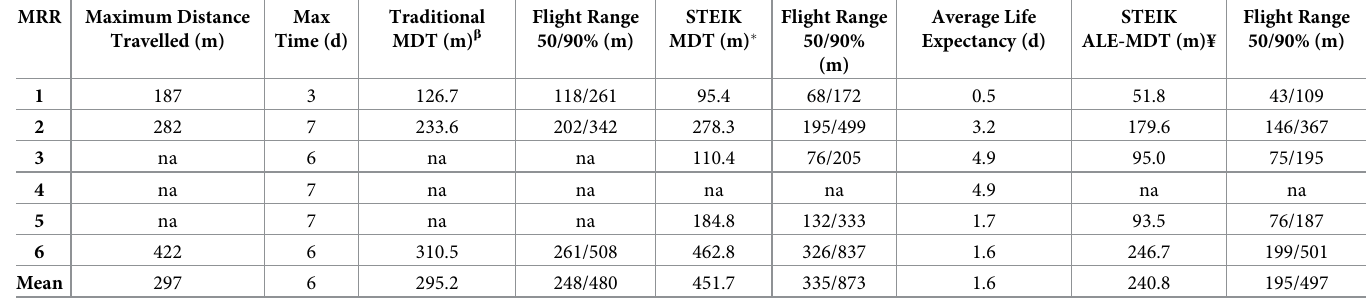
Table 4. Movement estimates male Aedes aegypti from six mark-release-recapture experiments in South Innisfail, Australia. Spatially and Temporarily Evolving Iso- tropic Kernel (STEIK) framework compared with the traditional annulus-based method. The STEIK framework allows for estimates of movement based on average life expectancy and from multiple release points (MRR 3 & 5).